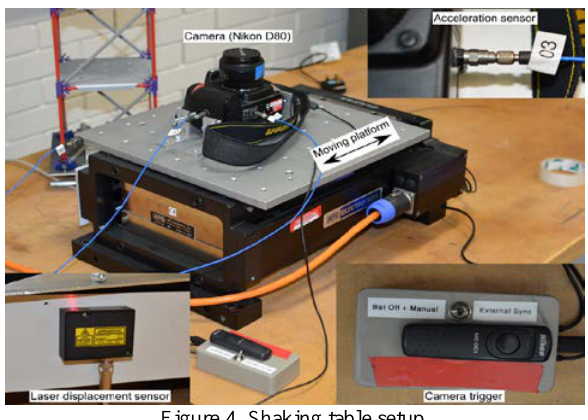
Figure 4. Shaking table setup.